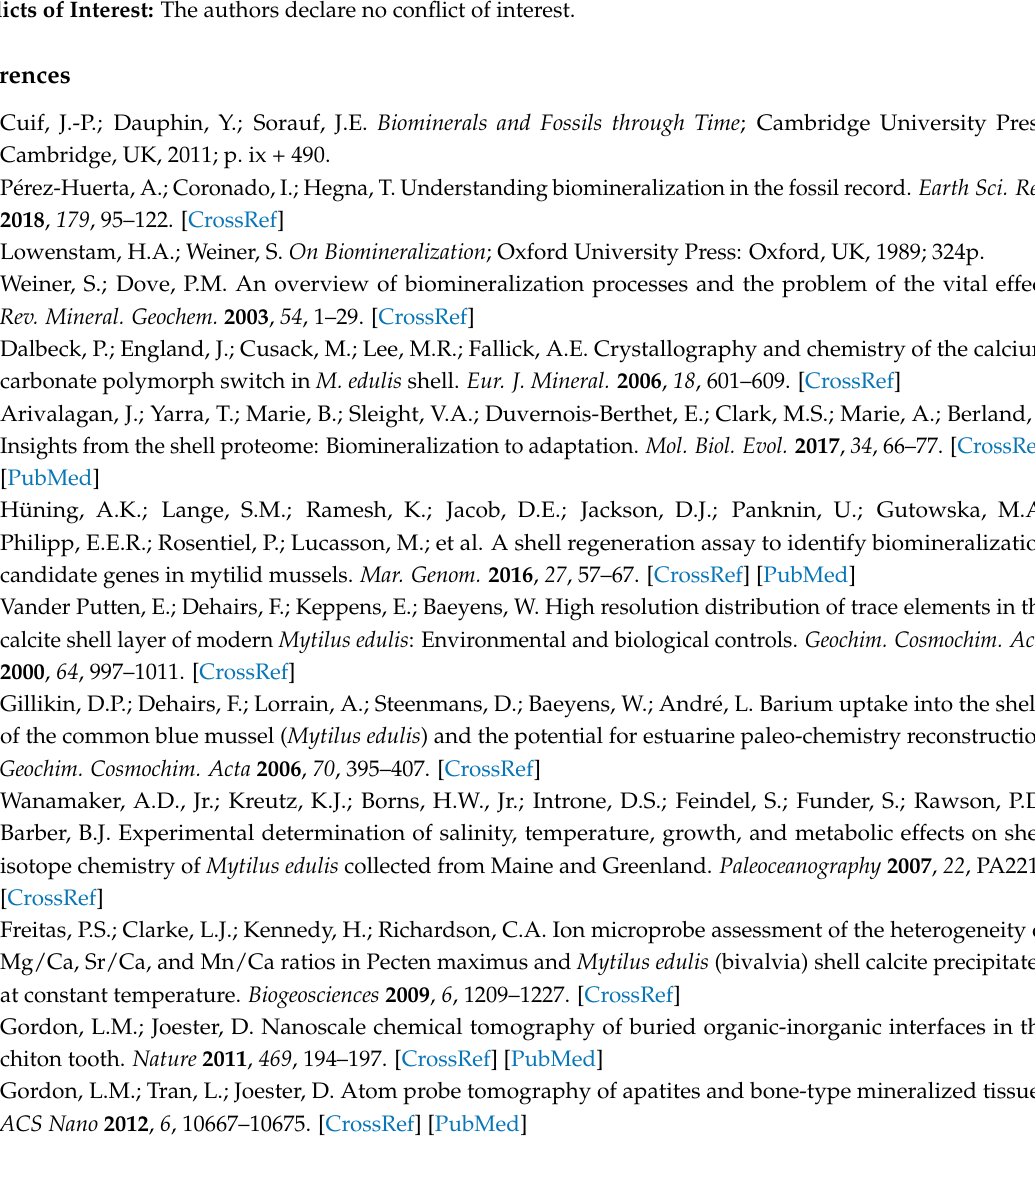
Table S1: APT Raw Chemistry Data, Table S2: APT Bulk Ionic Chemistry